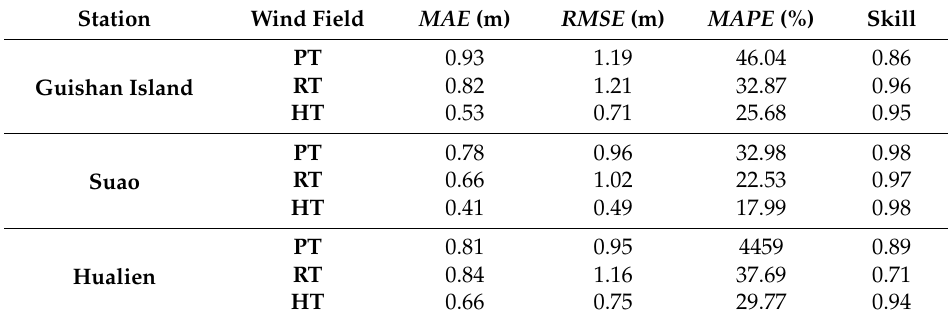
Table 2. Statistical errors of the model–data difference for significant wave height (SWH). Station Wind Field MAE (m)